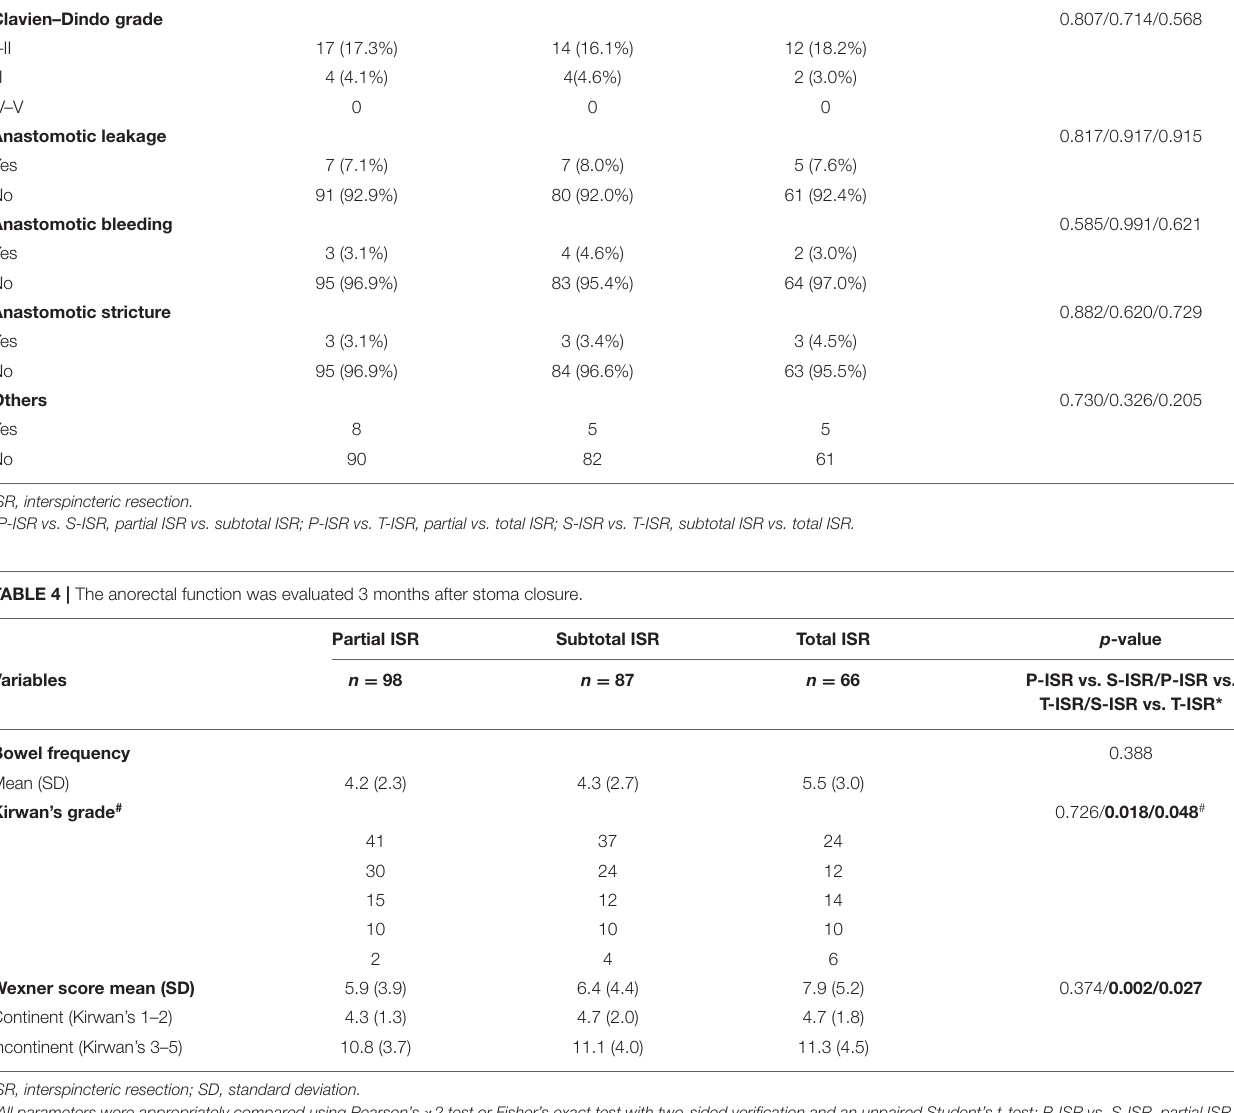
T-ISR/S-ISR vs. T-ISR*